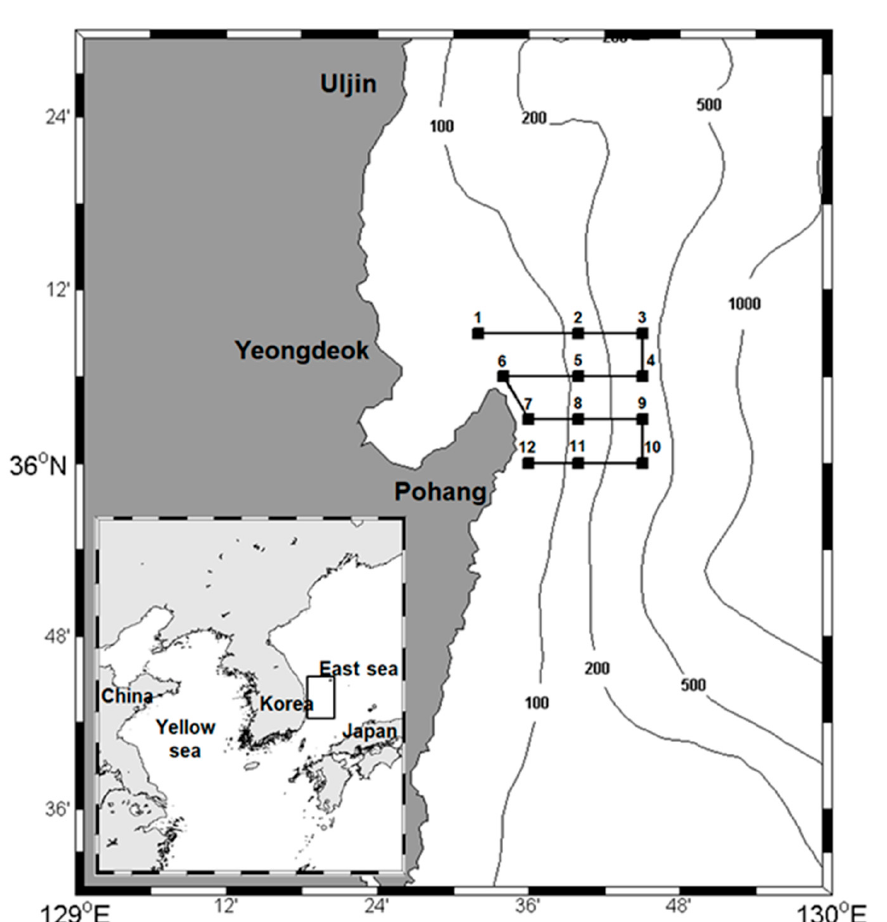
Figure 1. Study area showing the acoustic transects (black line), CTD stations (black square), and net stations (black square) in the coastal southwestern East Sea, Korea. Bathymetric contours are at 100, 200, 500, and 1000 m. Table 1. Details of each acoustic transect survey from April to July 2010.